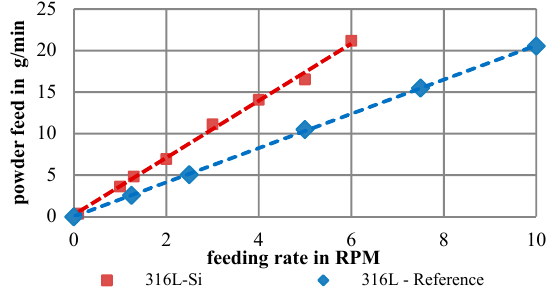
Figure 10. Powder feed line of the investigated 316L-Si and a 316L reference powder.